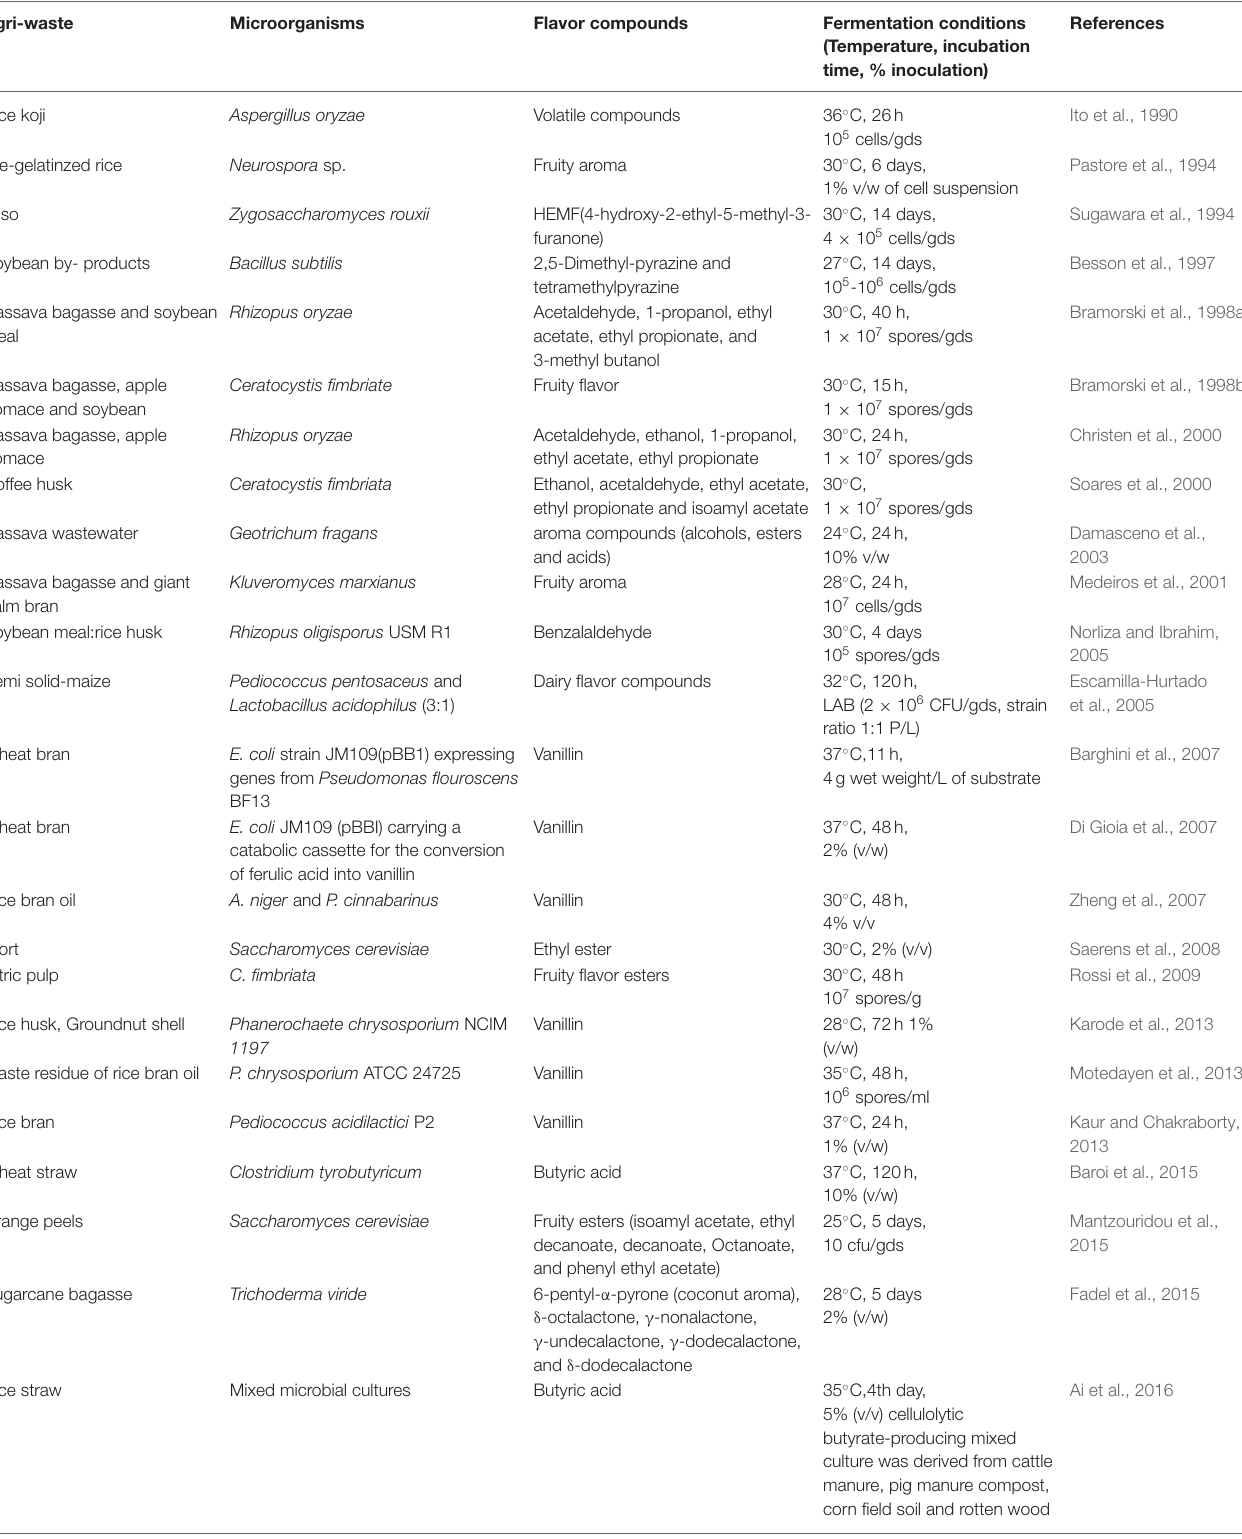
TABLE 1 | Microbial production of flavor compounds using different